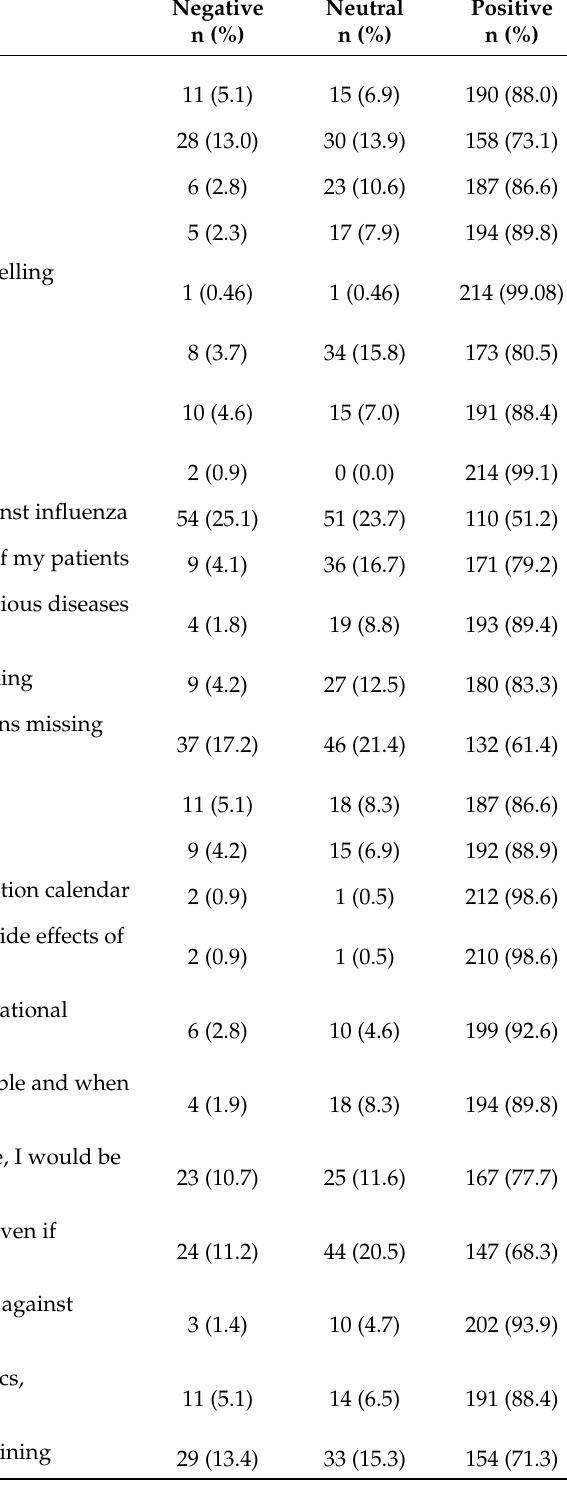
Table 1. ACVECS questionnaire: frequencies and percentages of students showing negative, neutral and positive